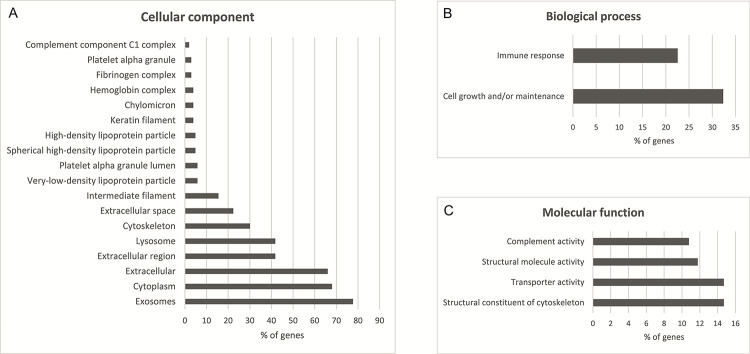
Gene ontology enrichment analysis of identified proteins from EVs with two or more unique peptide–containing proteins and p-value ≤0.05 (Holm-Bonferroni corrected) performed with FunRich 2.1.2 software using human genome as a background.A) Cellular component enrichment analysis, B) molecular function enrichment analysis, and C) biological process enrichment analysis.